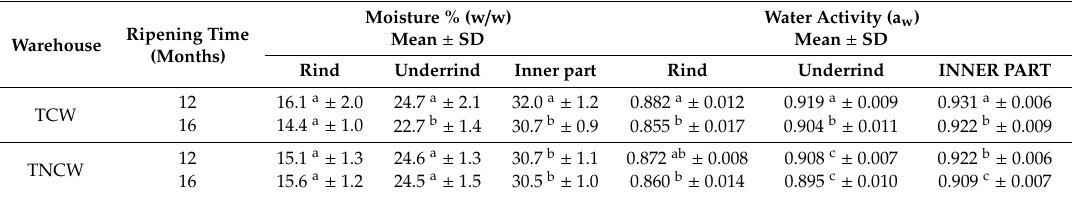
Table 2. Moisture content and water activity (a w ) of Nostrano Valtrompia cheeses ripened for 12 and 16 months in temperature conditioned warehouse (TCW) and traditional non conditioned warehouse (TNCW). Ripening Time Warehouse